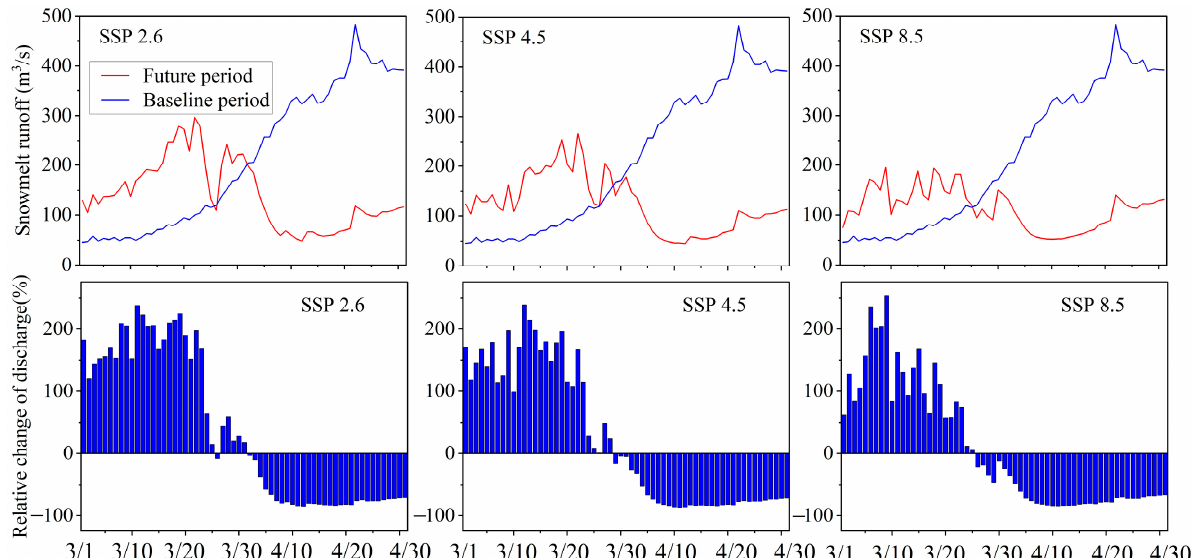
Figure 8. Annual average snowmelt runoff during 1980–2019 and 2020–2045 under SSP 2.6, SSP 4.5, and SSP 8.5 climate change scenarios, respectively.